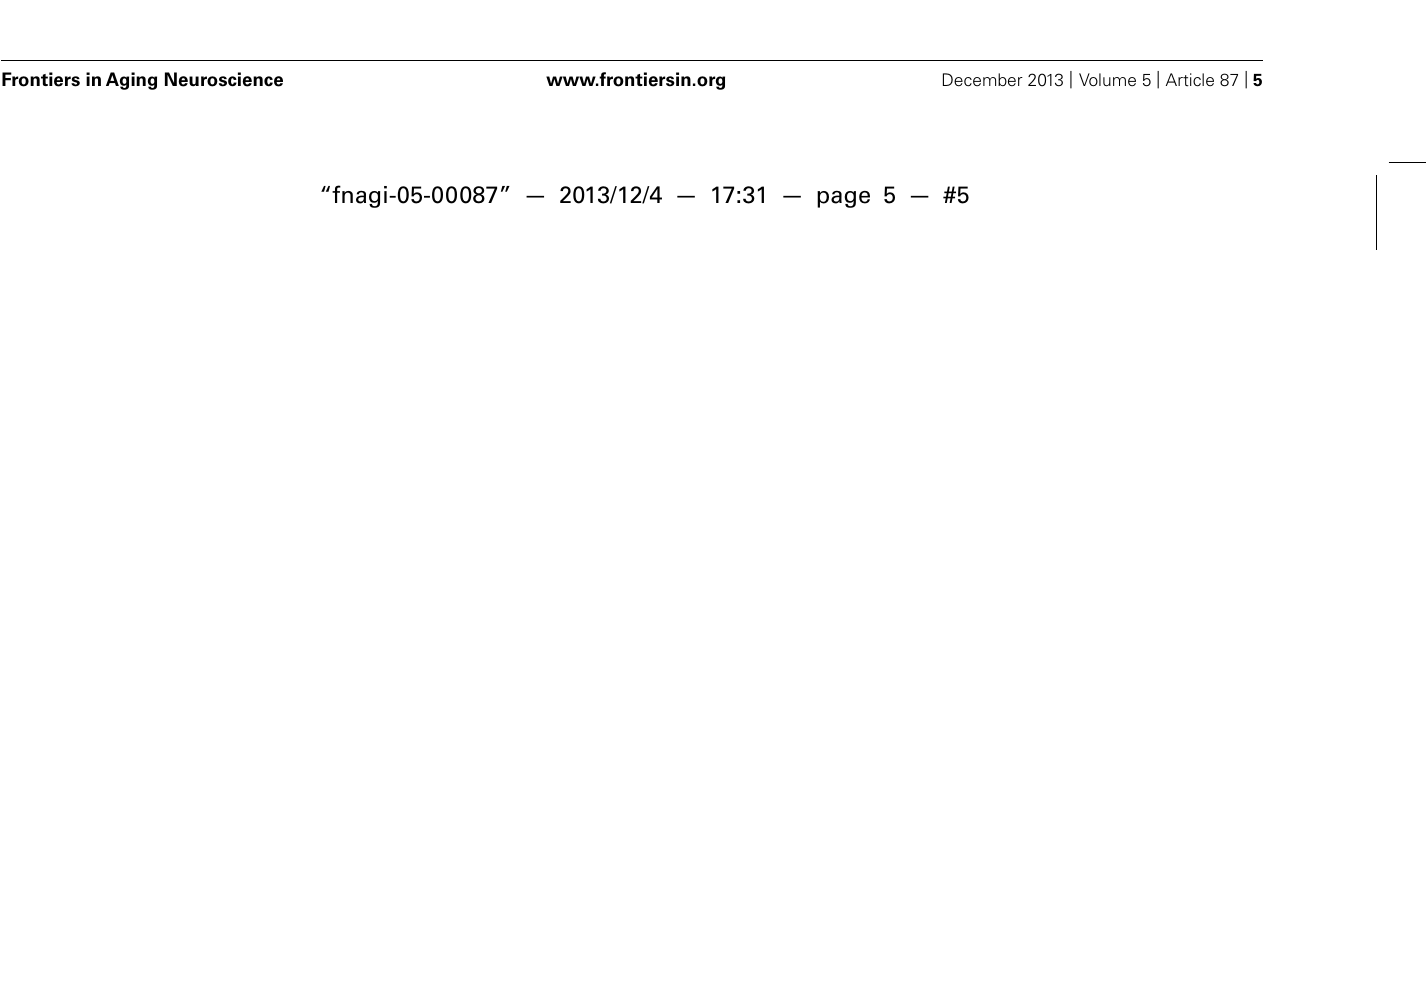
FIGURE 4 | MEP amplitude (130%AMT) sweeps recorded from one participant at baseline, immediately post and 30 min post stimulation for sham (A) unilateral (B) and bilateral (C) conditions